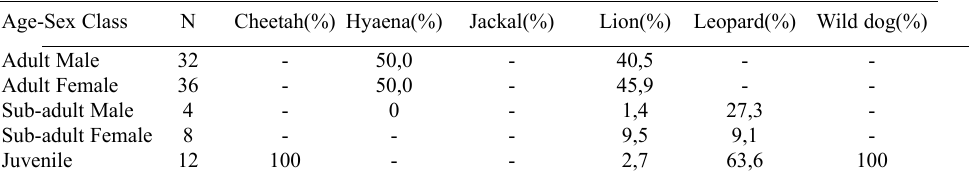
Proportional predation mortality of blue wildebeest Connocheatus taurinus relative to each age and sex